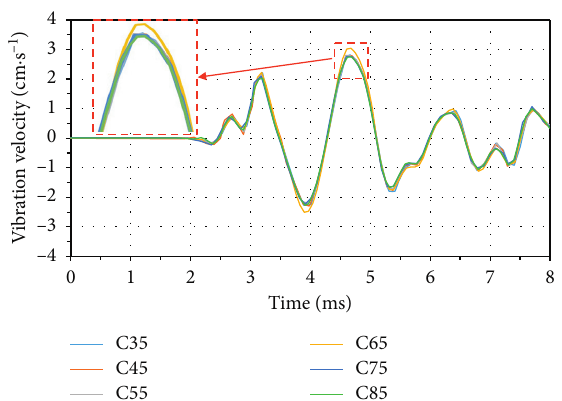
Figure 11: Velocity history curves under different concrete strength in the steel center. Contours of minimum principal stress min = –3.73102 e – 05, at elem# 181281 max = 2.78948 e – 06, at elem# 181280